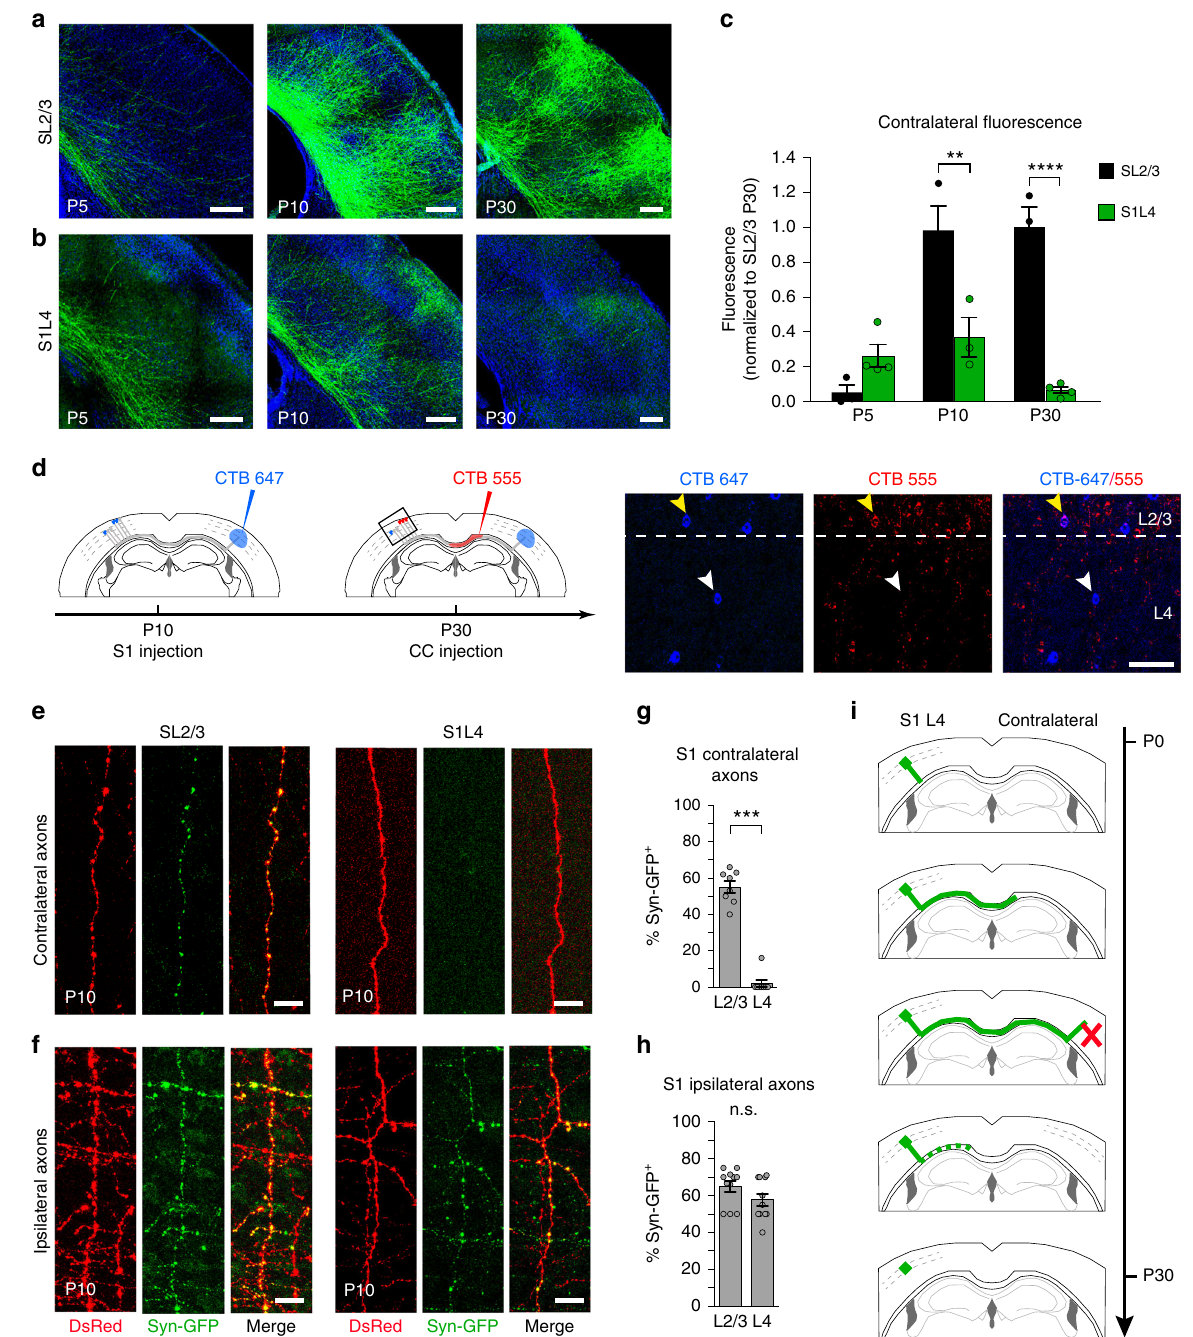
Fig. 4 Transient S1L4 callosal axons do not progress to terminal innervation. a , b Comparison of the dynamics of contralateral SL2/3 and S1L4 axons. SL2/3 axons labeled with GFP progress to terminal innervation. S1L4 contralateral axons labeled with GFP following E14 IUE in Rorb-Cre mice are unable to form contralateral columns. c Quanti fi cation of GFP axons in the contralateral plate as shown in a , b . Values are normalized to the mean fl uorescence of SL2/3 at P30. Mean ± SEM (error bars) ( n = 3 animals per stage and condition, n = 18 mice total). P value SL2/3/S1L4 ≤ 0.000, p value Fluorescence/time ≤ 0.0001 (two- way ANOVA ( n = 18): F SL2/3/S1L4 (1, 14) = 39.19, F Fluorescence/time (2, 14) = 18.96). P value ** ≤ 0.01; **** ≤ 0.0001 (post hoc with Tukey ’ s test). d Scheme of experiments performing sequential injections of CTB in the cortical plate and CC. The boxed area indicates the approximated location of S1 region corresponding to images shown on the right. White arrows indicate an L4 neuron of a P30 brain that pruned its P10 contralateral projection (blue only neuron); yellow arrows indicate an L2/3 neuron that reached the contralateral plate at P10 and stabilized this projection (blue and red). e Images of axons from SL2/3 or S1L4 neurons electroporated with CMV-synaptophysin-GFP (Syn-GFP; green) and pCAG-DsRed (DsRed; red) invading the contralateral plate. f Ipsilateral axons extending from SL2/3 or S1L4 neurons electroporated with CMV-synaptophysin-GFP and DsRed. g , h Quanti fi cations of the percentage of contralateral axons ( g ) or ipsilateral axons ( h ) containing synaptophysin. Mean ± SEM (error bars) ( n = 100 – 150 axons per condition, n = 3 animals per condition). *** P value ≤ 0.001 and (n.s.) non signi fi cant ( χ 2 test). i Working model of S1L4 axonal re fi nement during postnatal development. Scale bars represent 200 µ m ( a , b ), 50 µ m ( d ), and 10 µ m ( e , f ). Source data are provided as a Source Data fi